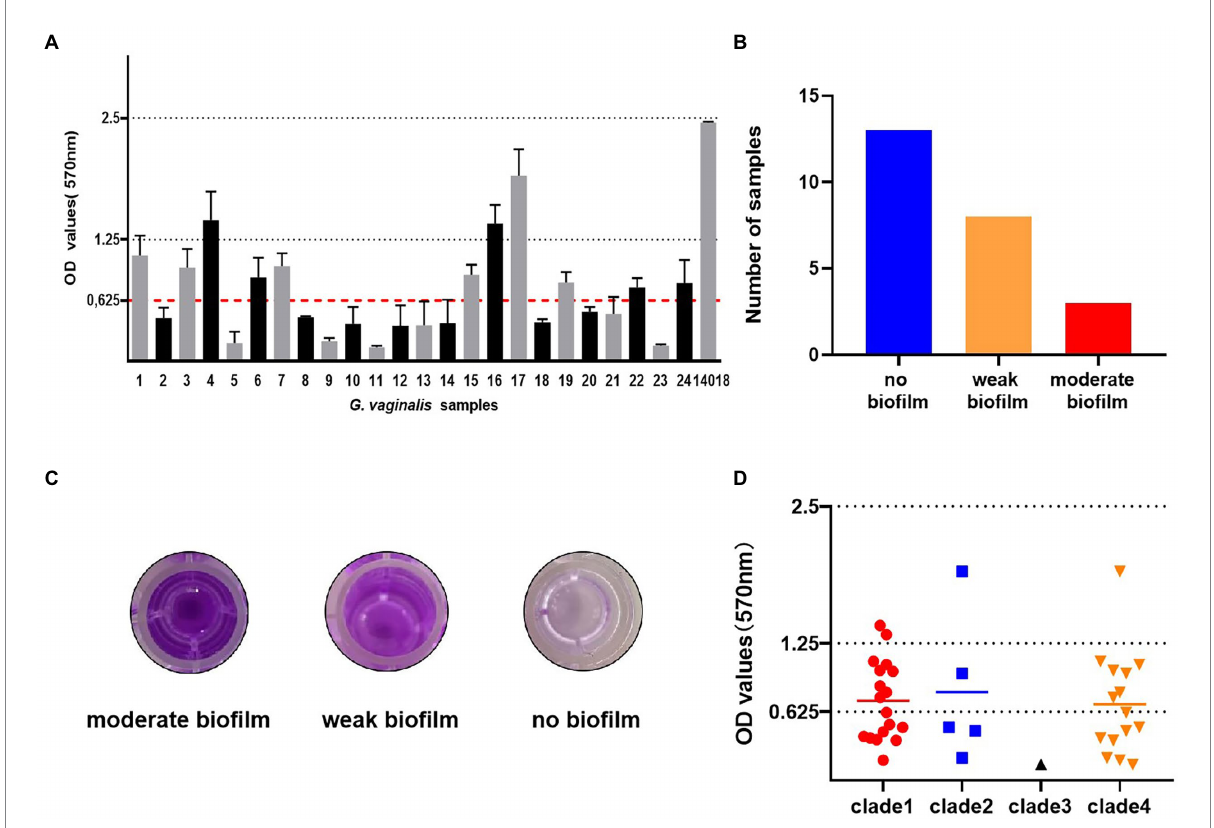
FIGURE 1 Biofilm formation of G. vaginalis clinical isolates and a laboratory reference strain. (A) The optical densities of G. vaginalis clinical isolates and ATCC14018. (The calculated cut-off optical density value was 0.625. no biofilm: < 0.625; weak biofilm: 0.625–1.25; moderate biofilm: 1.25–2.5). (B) The number of samples with moderate biofilm, weak biofilm and no biofilm. (C) The appearance of biofilms in 96-well microplates, as determined by crystal violet staining. (D) The relationship between biofilm formation and clades. Biofilms were stained with crystal violet and the amount of biofilm formation was measured at 570